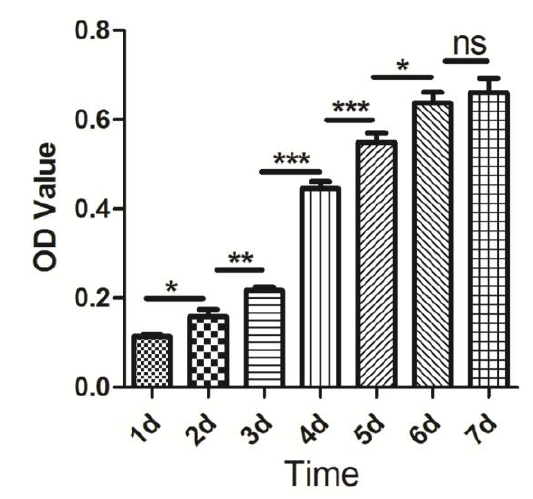
Figure 3. Proliferation assessment of porcine skeletal muscle satellite cells. CCK-8 analysis for porcine skeletal muscle satellite cells proliferation at days 1, 2, 3, 4, 5, 6 and 7. A p value of <0.05 is shown as *, p<0.01 is shown as **, and p<0.001 is shown as ***. No significance is shown as